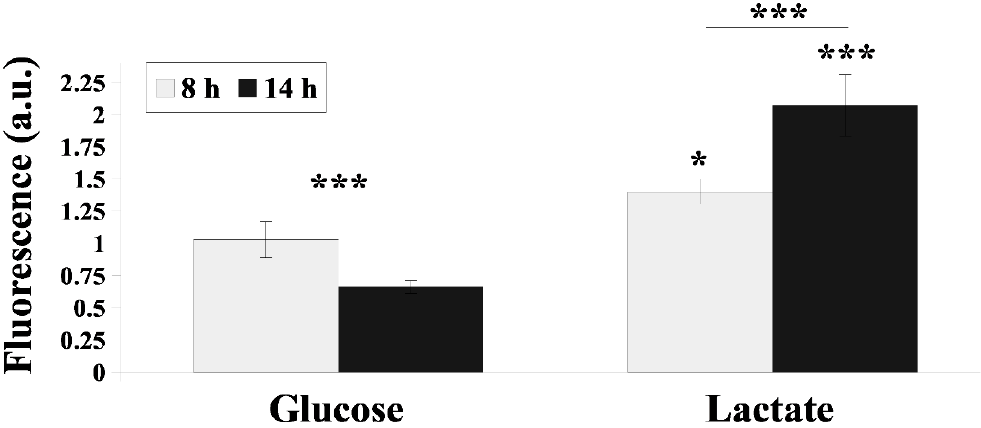
Figure 1. Cdr1p-dependent rhodamine 6G (R6G) efflux in C. albicans CAF2-1 strain during growth (8 and 14 h) in YPD (glucose) and YPL (lactate) media. The data are presented as normalized (=1 for 8 h YPD-grown strain) fluorescence in- tensity of extracellular R6G (mean ± SD, n = 3). Statistical analysis compared data during different growth phases (above lines) or compared YPD- and YPL-grown strains (above bars) (*, p < 0.05; ***, p < 0.001).